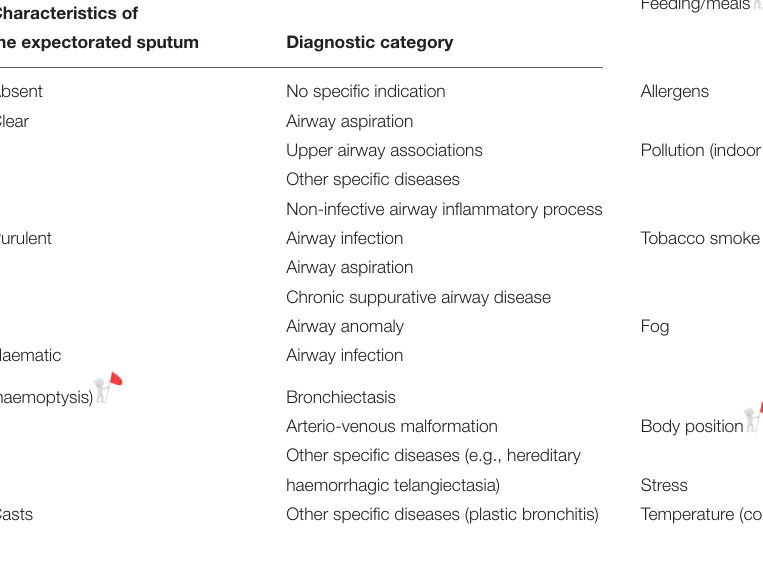
TABLE 7 | Expectorate and potential diagnostic category.